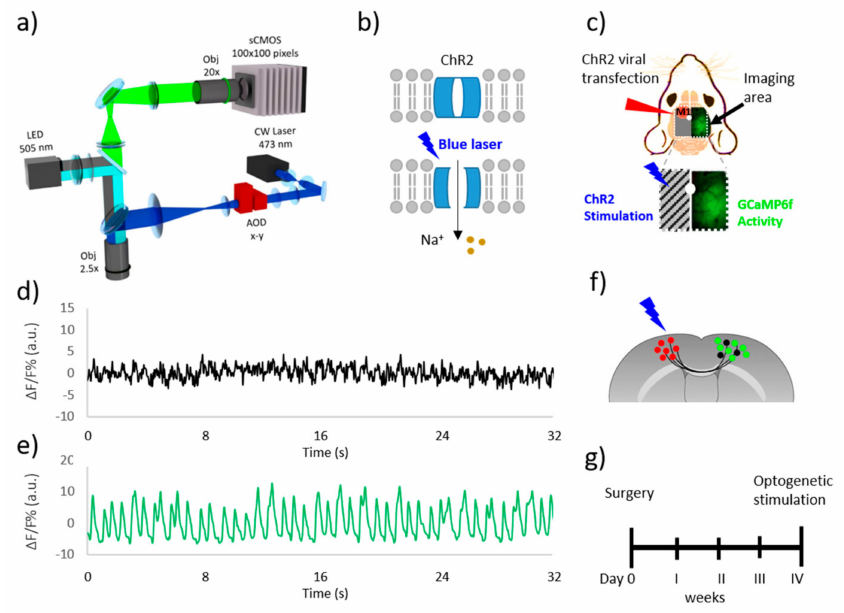
Figure 1. Double-split illumination path. ( a ) Schematic representation of wide-field microscope for the simultaneous laser stimulation and cortical imaging. ( b ) Schematic representation of Channel rhodopsin 2 structure. ( c ) Schematic representation of field of view for inter-hemispheric optogenetic investigation in GCaMP6f mice: ChR2-transfected M1 (red circle) in the left obscured hemisphere is stimulated by the 473 nm blue laser; cortical activity is revealed in the right hemisphere. ( d ) Left hemisphere ∆ F/F signal during resting state; ( e ) Right hemisphere ∆ F/F signal during resting state; ( f ) Schematic cartoon of interhemispheric connectivity of homotopic regions of the brain cortex via corpus callosum. The red spots represent ChR2-transfected neurons, the green spots represent excitatory neurons expressing the calcium indicator GCaMP6f, the black spots represent inhibitory neurons. ( g ) Experimental timeline. AOD: Acousto-optic